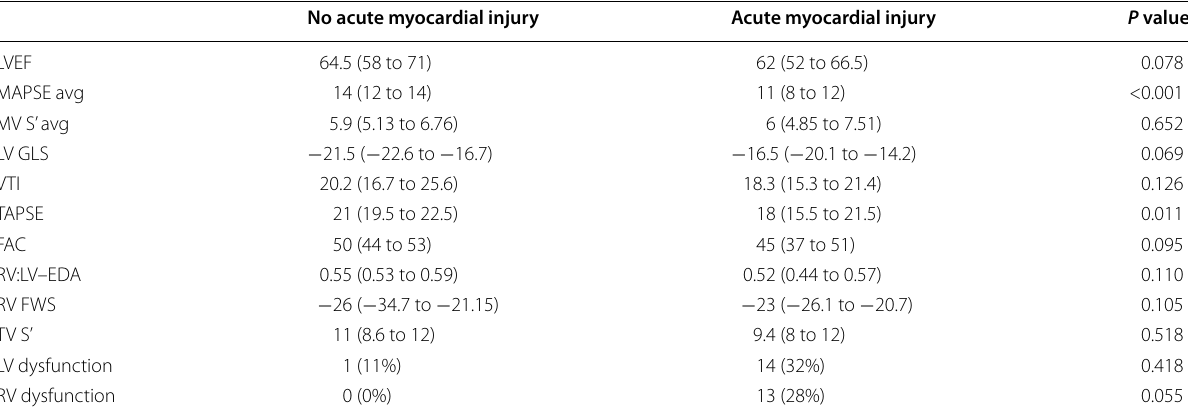
Table 4 Echocardiographic variables stratified by acute myocardial injury